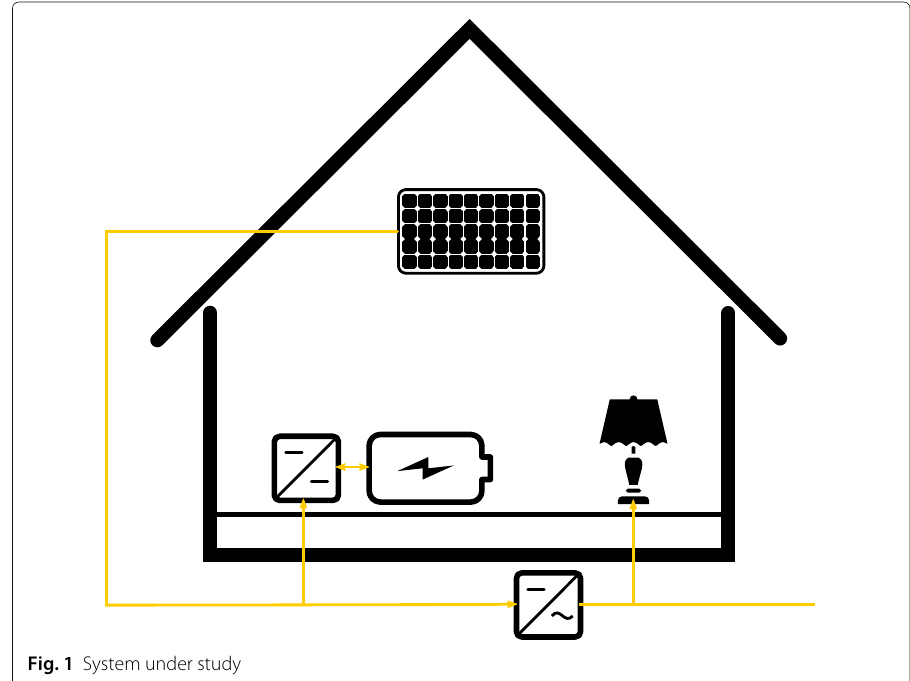
Fig. 1 System under study